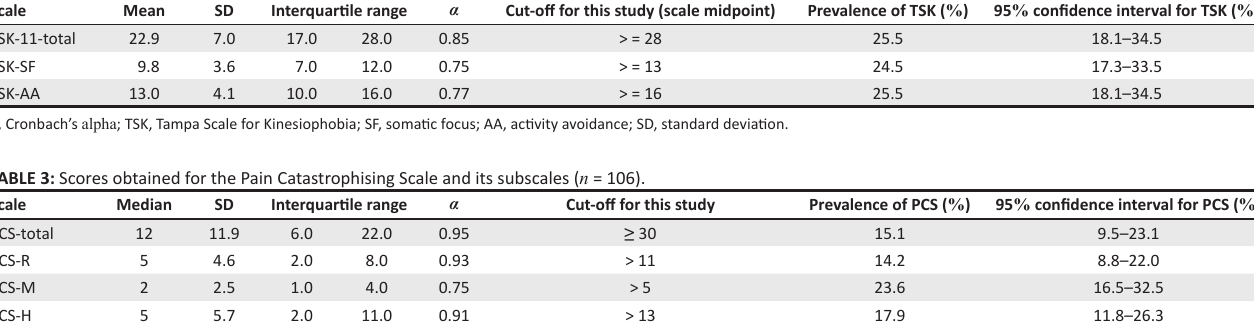
TABLE 2: Scores obtained for the Tampa Scale for Kinesiophobia-11 scale and its subscales ( n = 106). Scale Mean SD